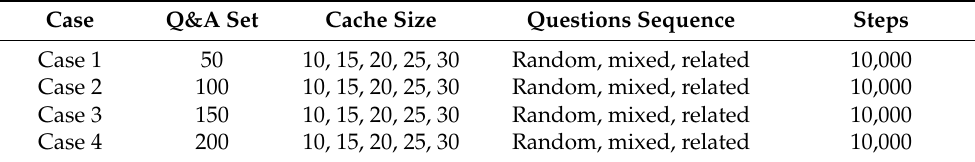
Table 3. Information on experimental cases.